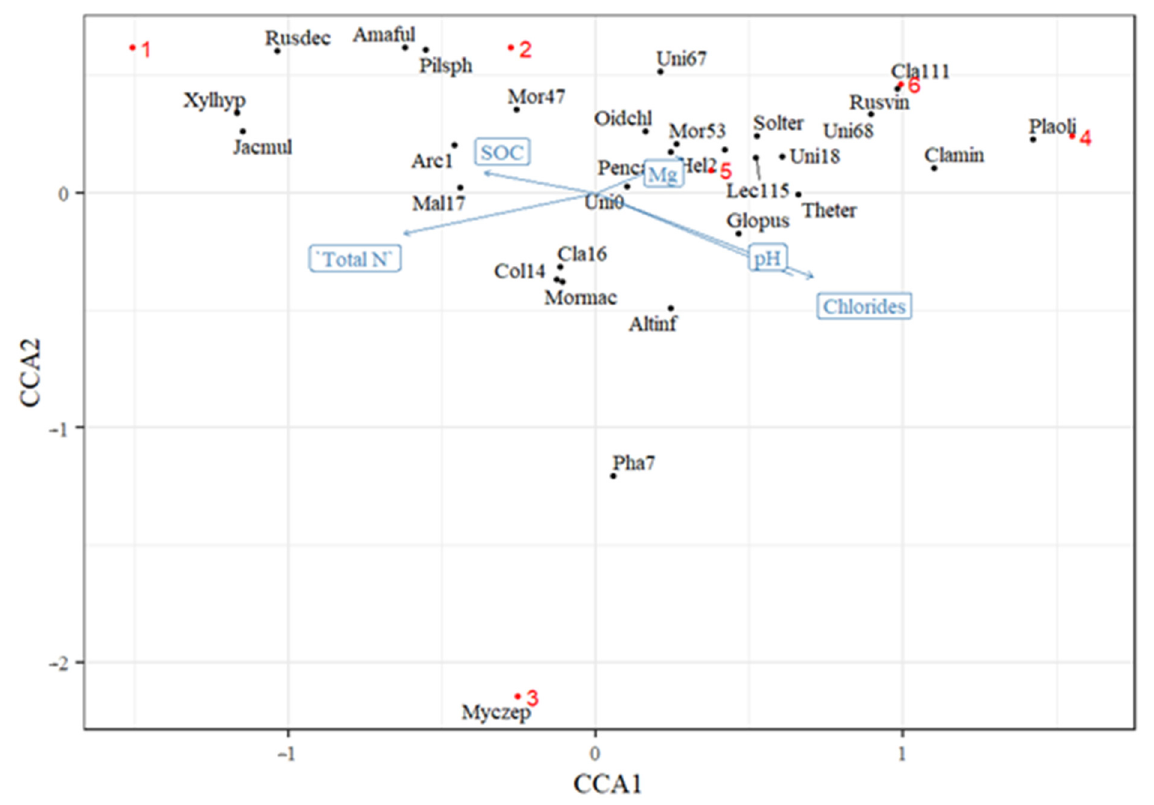
Figure 9. Canonical correspondence analysis (CCA) of the selected chemical variables (pH CaCl2 , SOC, total N, Mg 2+ , and Cl − ) and the most common 30 fungal OTUs. Red numbers represent study sites: 1 is the mature forest stands; 2—clear-cuts; 3—the 1st year plantations; 4—the 2nd year plantations; 5—the 3rd year plantations; 6—the 4th year plantations. The first and second axes explain 32% and 30% of the variance. Abbreviations of fungal species are composed of the three-letter abbreviation of the species scientific name. If the fungal taxa were identified only to the genus level, abbreviations are composed of the three-letter abbreviation of the genus name and the last number of the identification code (full names of fungal out are given in Table 4).